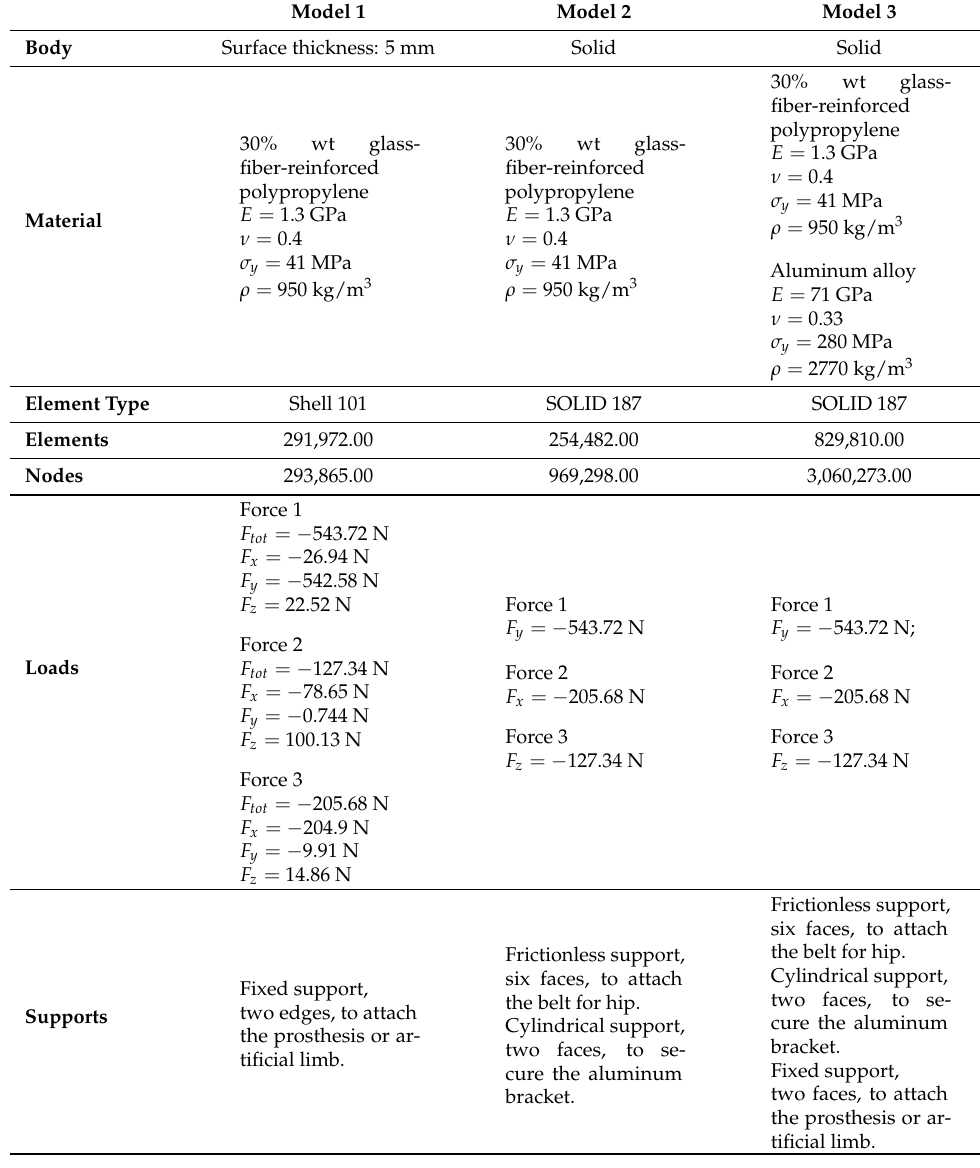
Table 4. Material properties and simulation